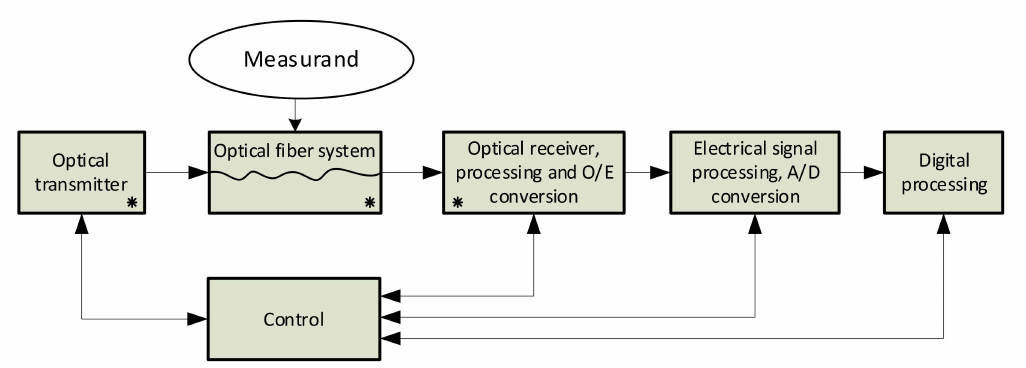
Figure 1. General architecture of modern optical fiber-based sensing